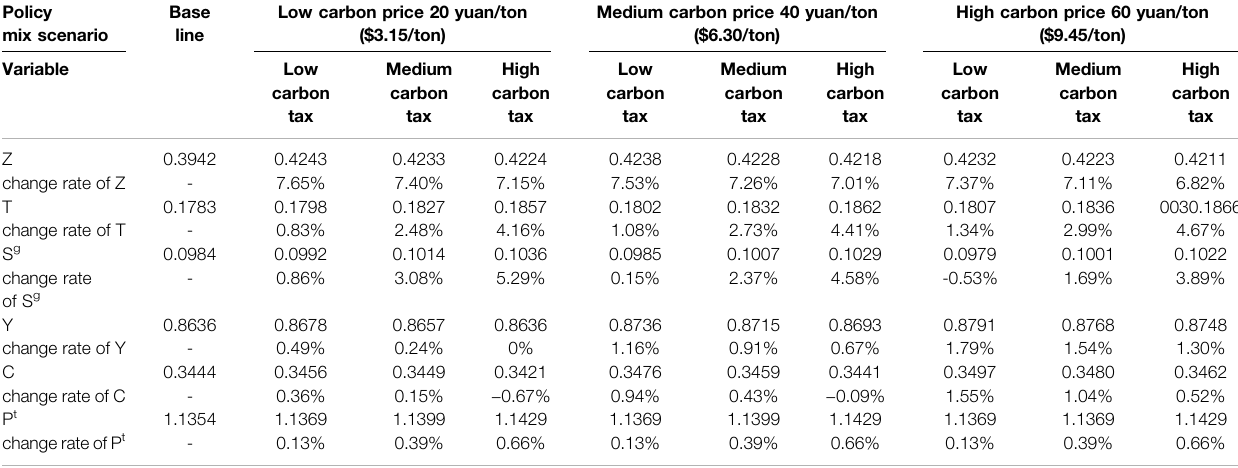
TABLE 6 | Simulation results of the “ carbon trading — carbon tax ” mixed policy (based on carbon trading). Policy mix